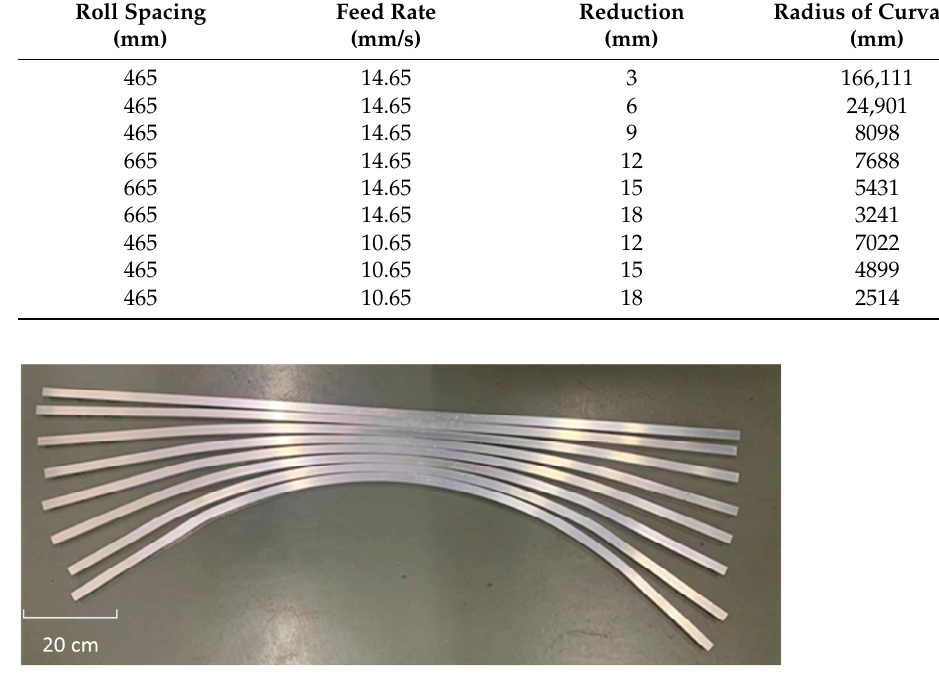
Figure 9. Partially Fixed Curvature Experimental Profiles.